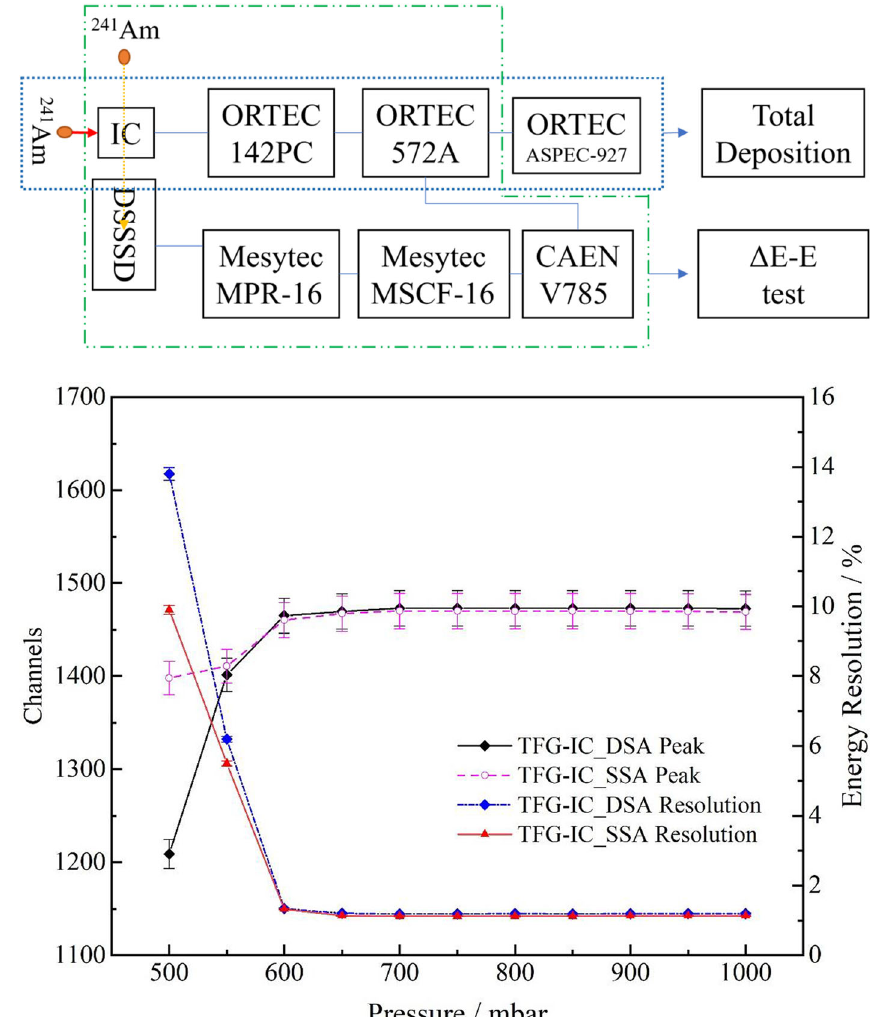
Fig. 4 Block diagram of the electronics used in the laboratory